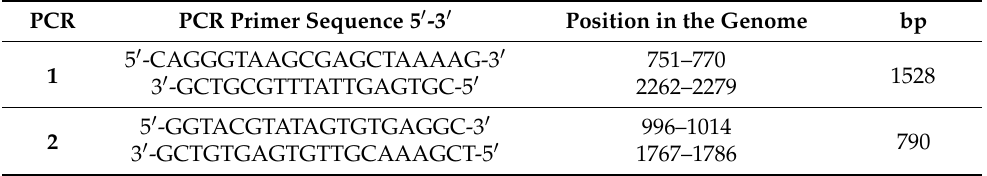
Table 2. Oligonucleotide primers used for the